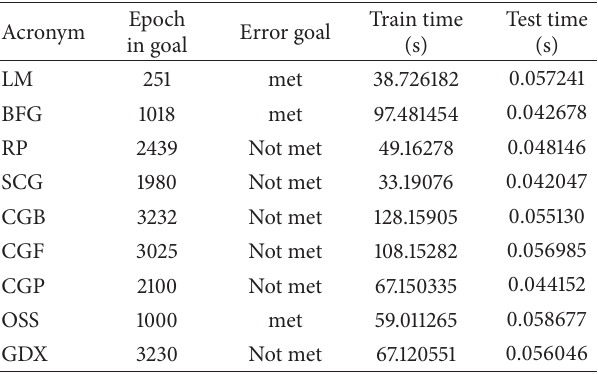
Table 7: The results of the variable training methods in the BPN with newcf function.